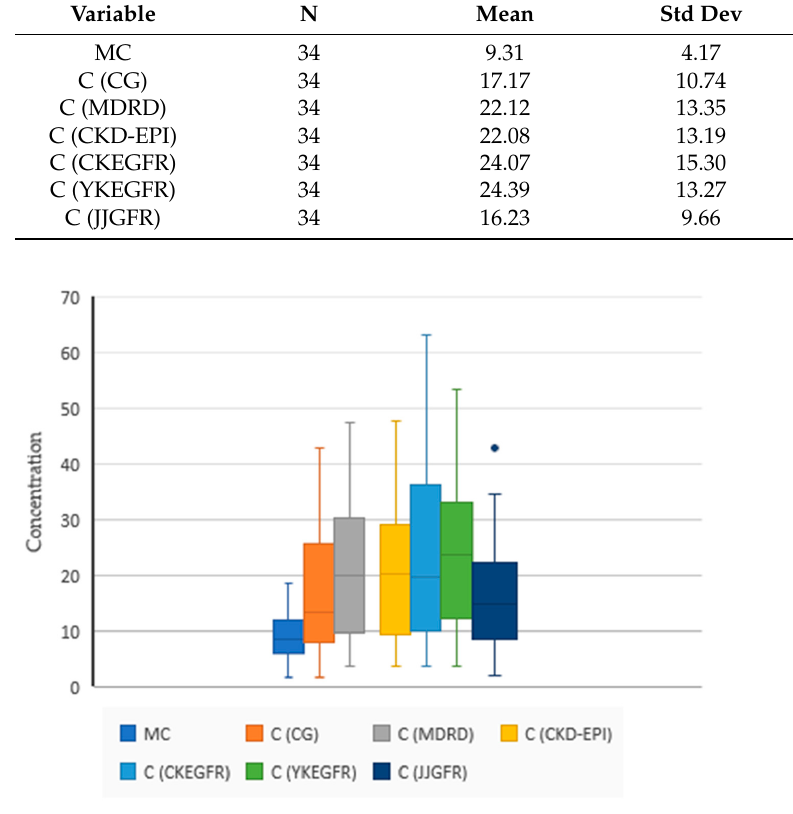
Figure 2. Summary statistics of the predicted (C) and measured concentrations (MC) of VCM with individual PK models based on different GFR estimators. N = 34, MC 9.31 (4.17), C (CG) 17.17 (10.74), C (MDRD) 22.12 (13.35), C (CKD-EPI) 22.08 (13.19), C (CKEGFR) 24.07 (15.30), C (YKEGFR) 24.39 (13.27), C (JJGFR) 16.23(9.66). The blue dot is an outlier. One-way ANOVA (F (4165) = 2.1398, p =